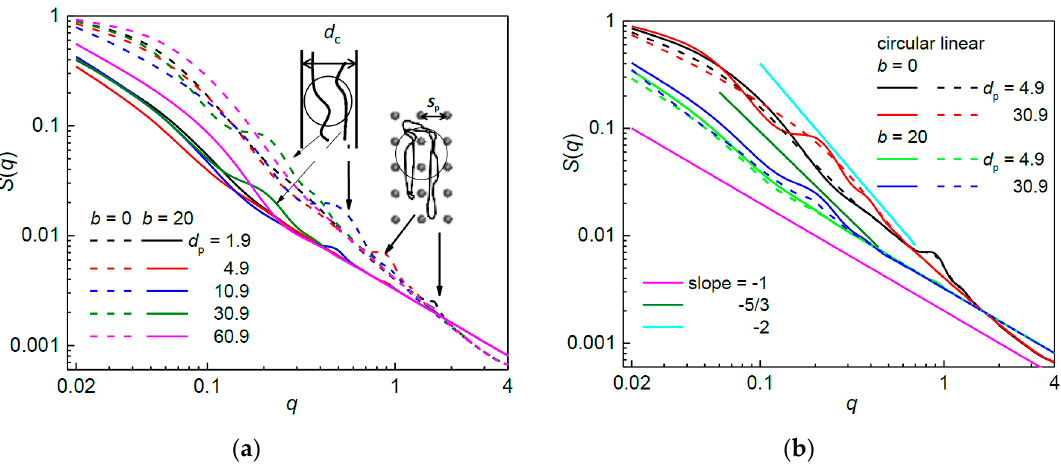
Figure 7. Structure factor for: a flexible and semiflexible circular chain ( a ); and for a flexible and semiflexible circular and linear chain ( b ), confined in an array of nanoposts of fixed passage width w p = 2 and various post diameters d p . In ( a ), the insets represent the preferred chain conformation associated with the humps (on the left: due to the local increase in density, on the right: due to the parallel fragments in adjacent volumes such as U-turns); and, in ( b ), the solid lines represent the characteristic slopes that might be expected for a biaxially confined chain.